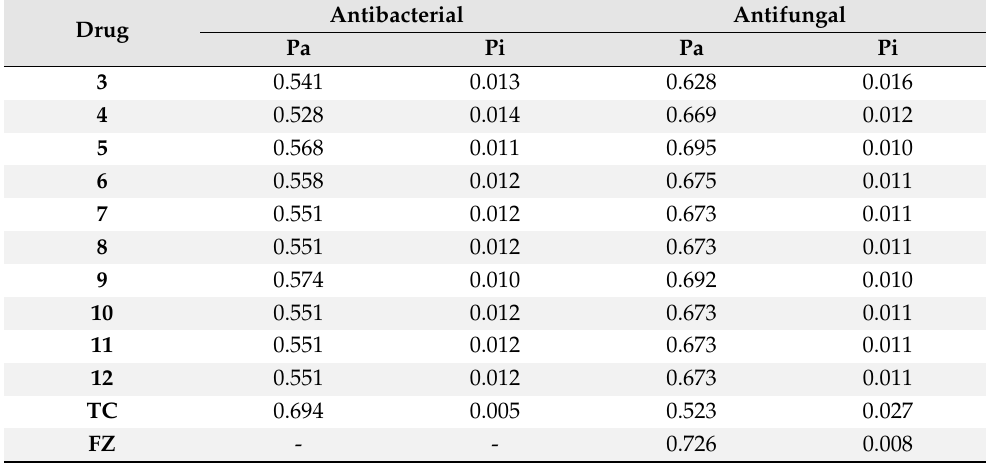
Table 1. PASS predicted biological activity of MDG esters 4 – 12